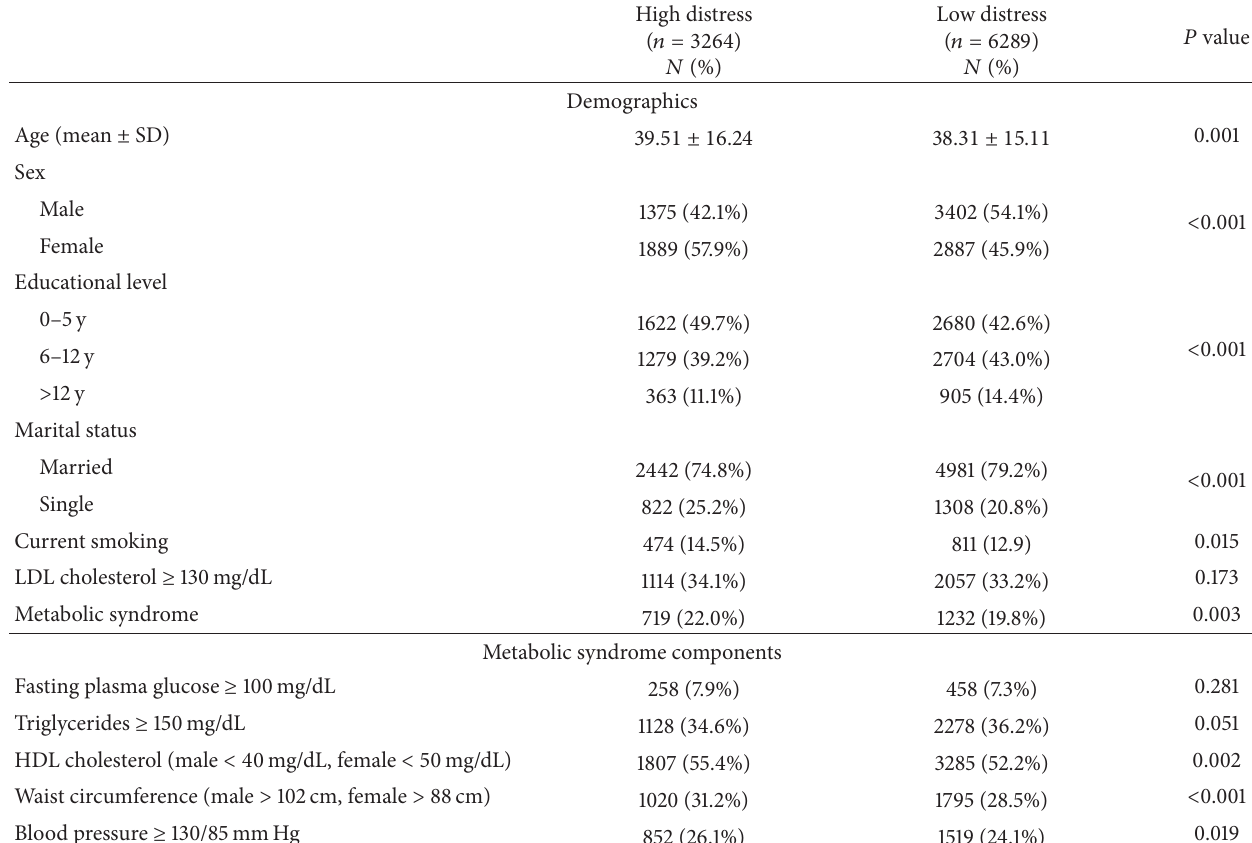
Table 1: Baseline characteristics according to distress